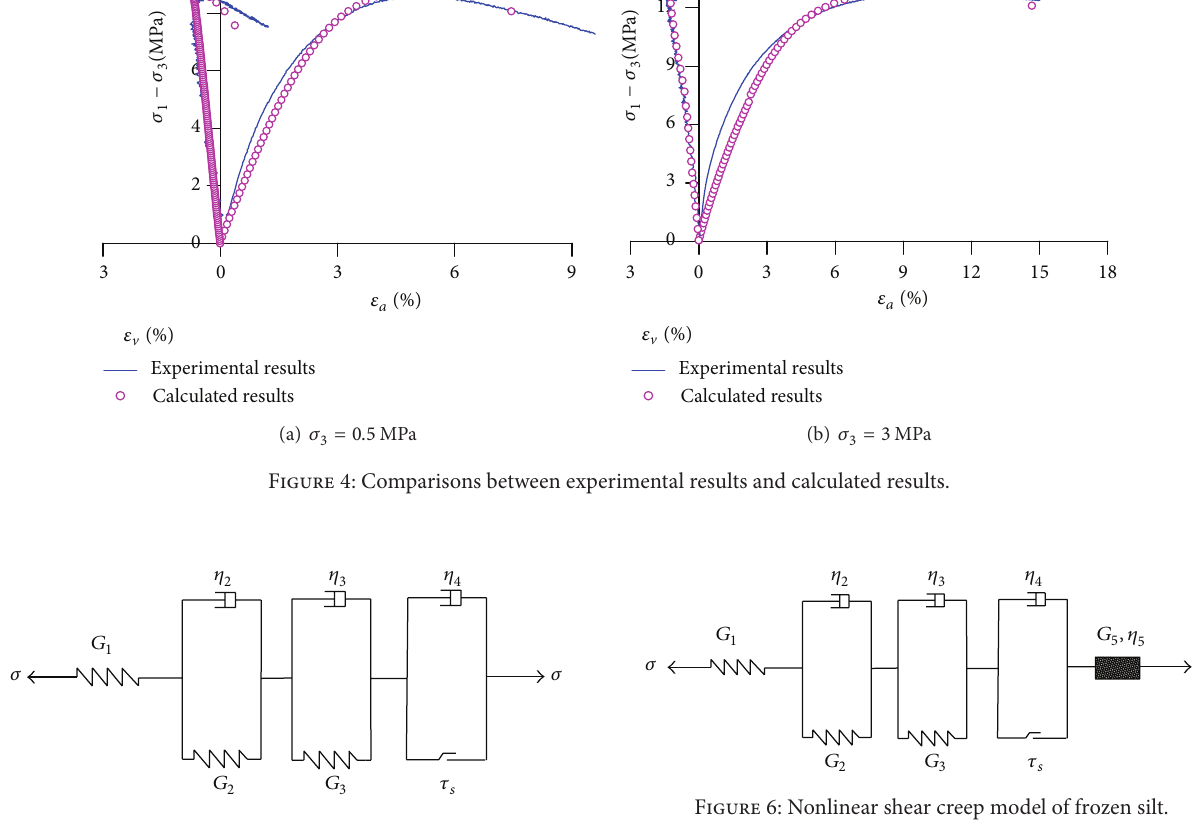
Figure 5: Shear creep model of frozen silt.